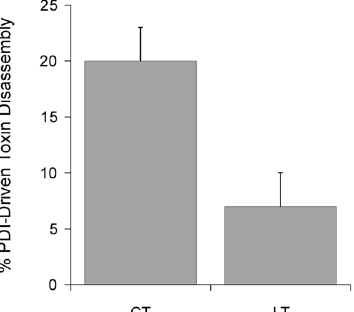
Figure 4. Comparative analysis of CT/LT disassembly by PDI. CT and LT were appended to the wells of a GM1-coated ELISA plate and exposed to reduced PDI for 1 h at 37 °C. After extensive washing, sequential incubations with primary and HRP-conjugated secondary antibodies were used to detect the A1 subunit. The percentage of toxin disassembly was calculated from the maximum A1 signal obtained from the corresponding untreated holotoxin. Error bars present the standard error of the means from four independent experiments with six replicate wells per